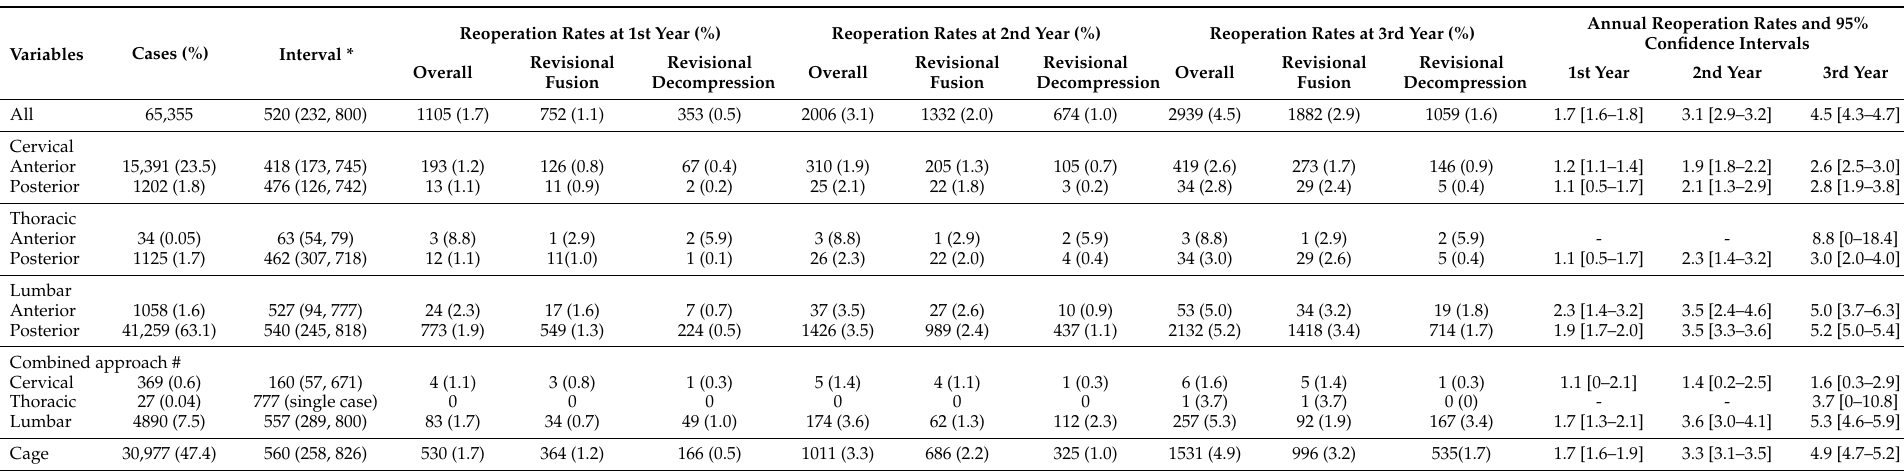
Table 4. Annual reoperation rates according to the surgical procedures.